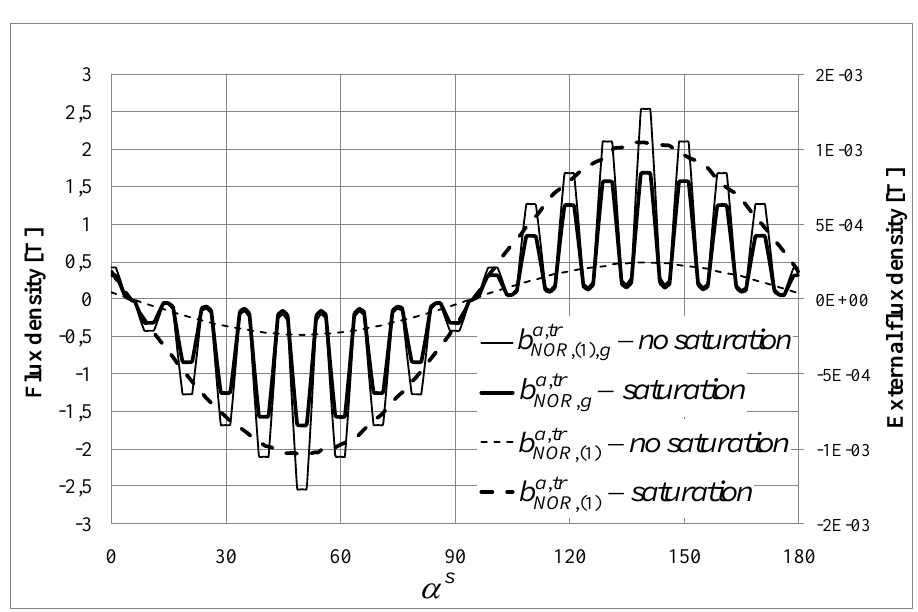
Figure 16. Variations of )( , and without saturation.